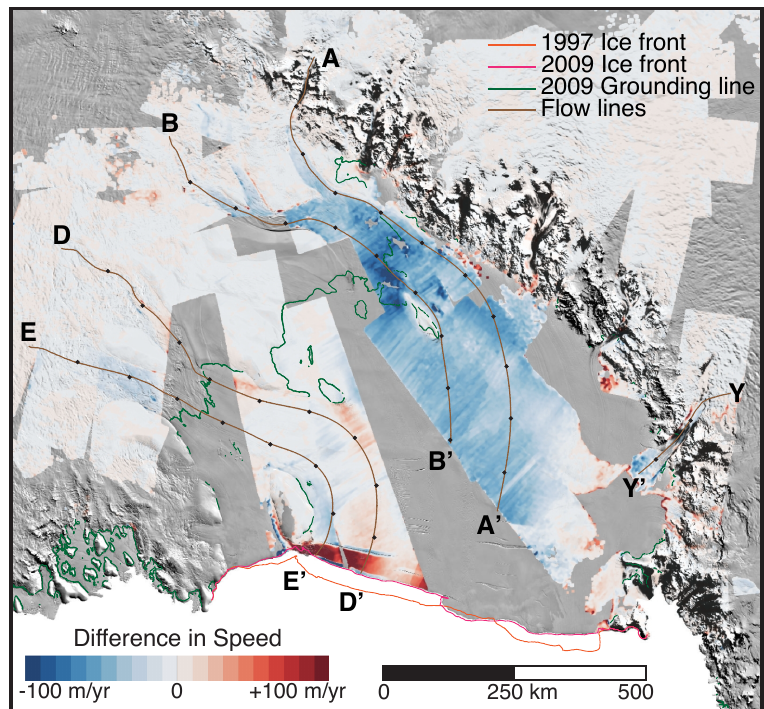
Fig. 2. Map of the difference in speed (2009–1997) detail, 1997 and 2009 ice front, and flow line plots for Ross Ice Shelf overlaid on MOA. Each flow line includes markers every 100km. Corresponding flow line plots are shown in Fig. 3. The dark red region on the ice shelf edge near Roosevelt Island indicates a pre-calving